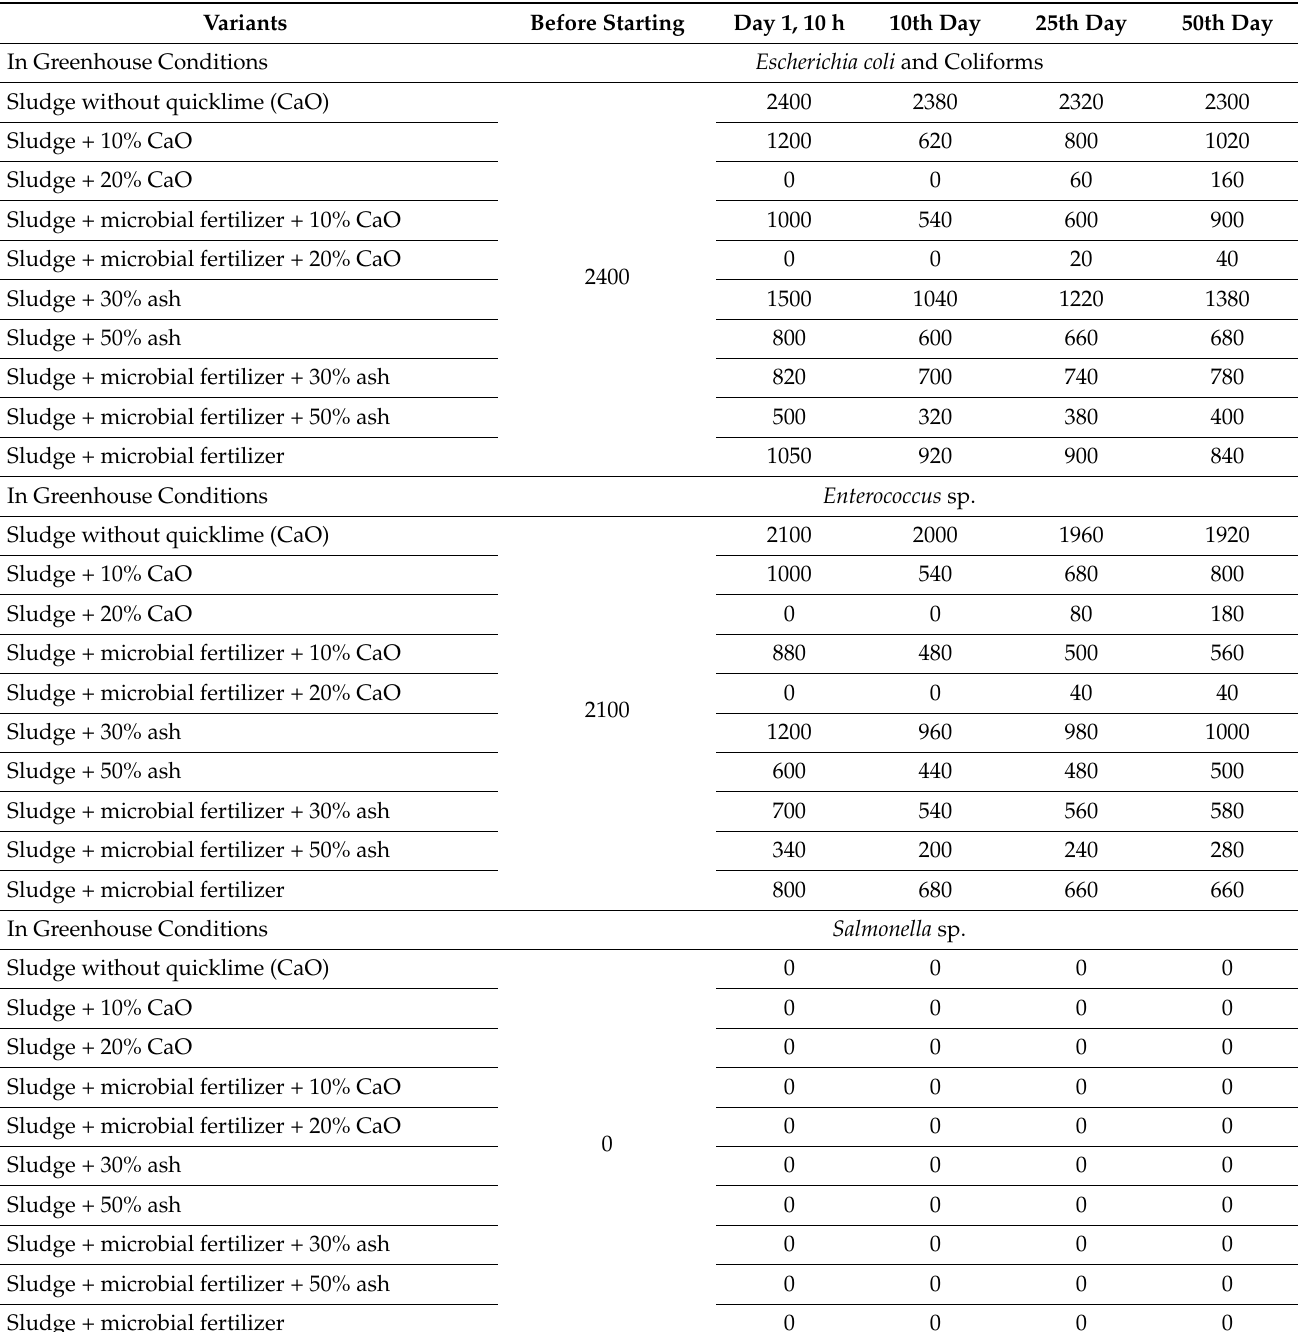
Table 3. Quantity and qualitative composition of pathogenic microflora in raw sludge (cfu/g) in